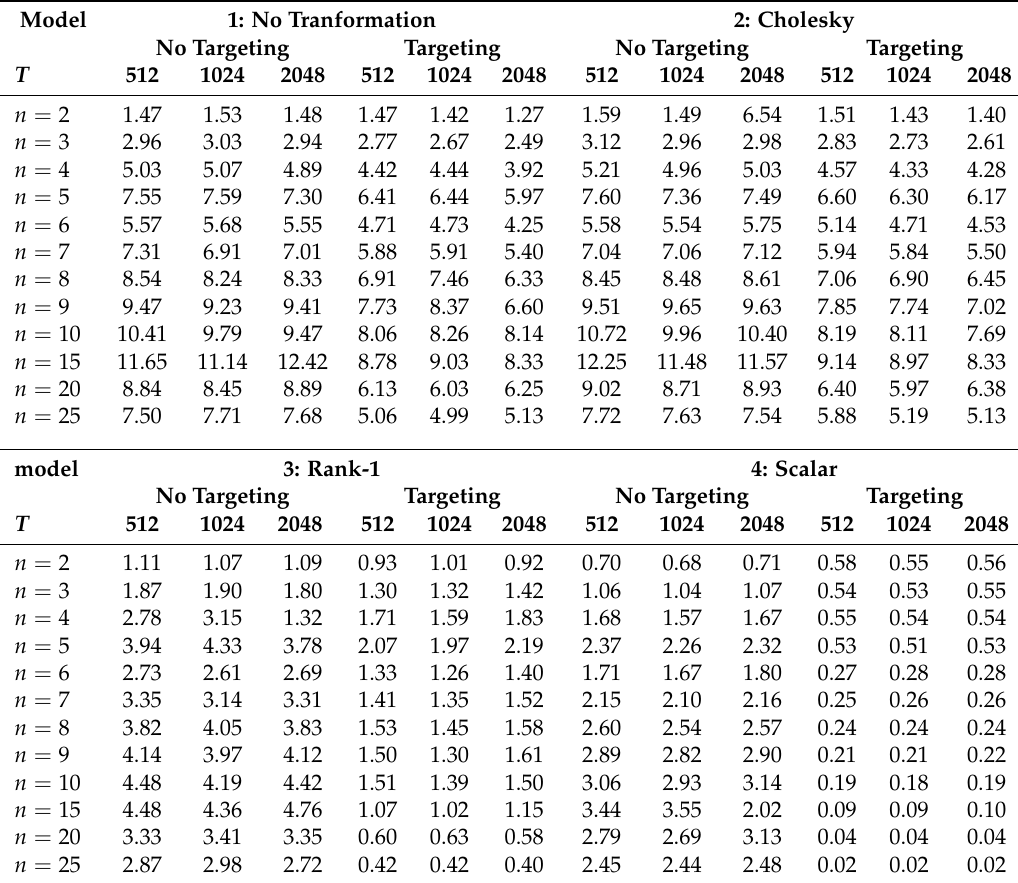
Table 2. Time ratios t N / t A